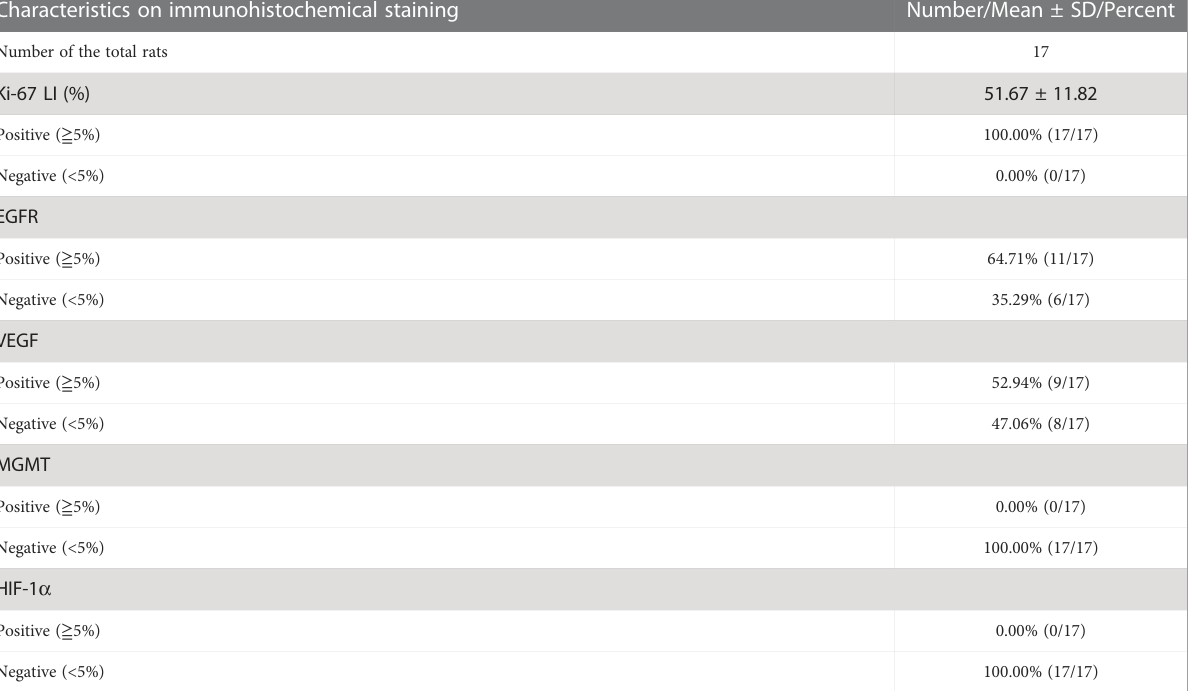
TABLE 2 Characteristics of tumor lesions on immunohistochemical staining.